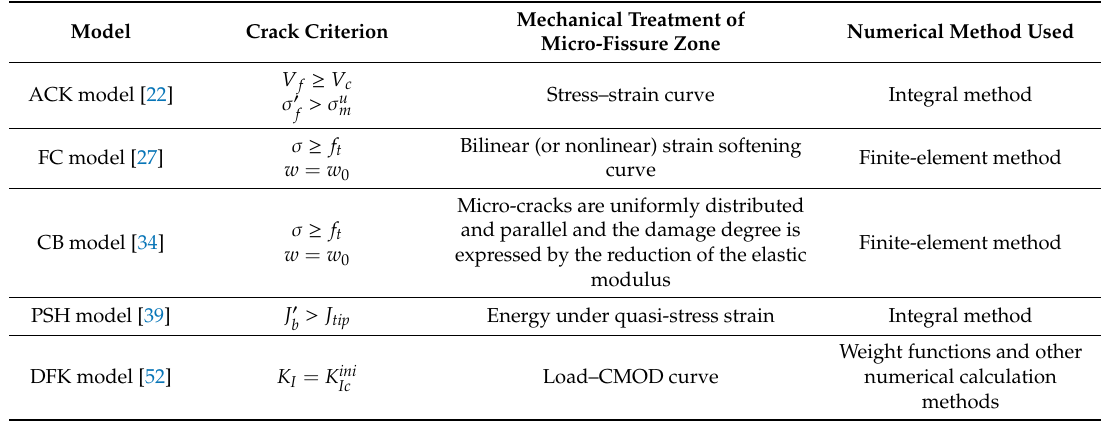
Table 1. Comparison of the five models for cementitious